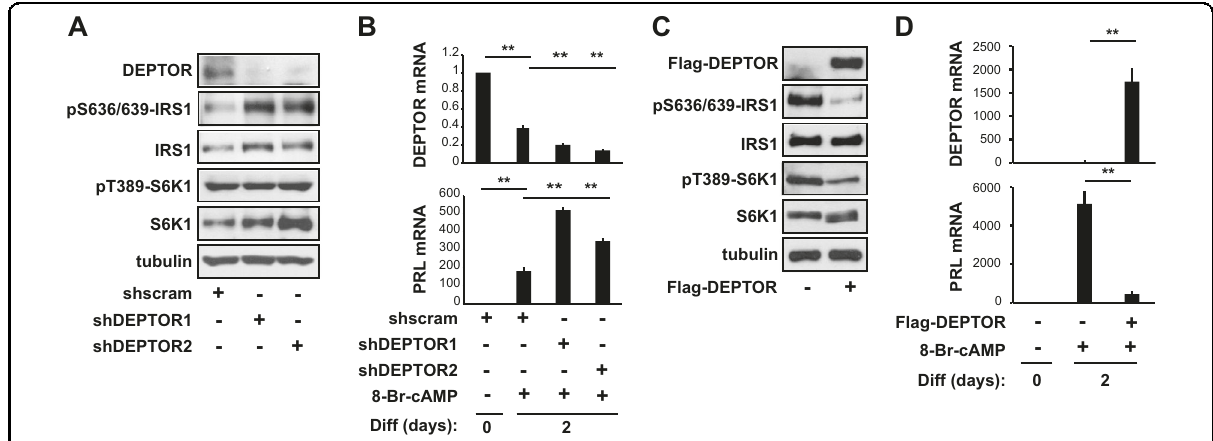
Fig. 4 DEPTOR is a negative regulator of decidualization. a , b Human endometrial stromal (hES) cells were infected with lentiviruses expressing two different DEPTOR shRNAs or scrambled shRNA and were then selected by puromycin for 5 days. a Cells were lysed and then analyzed by western blotting. b After 2 days of differentiation, the cells were lysed and subjected to quantitative RT-PCR. c Cells were transfected with Flag-DEPTOR, lysed, and analyzed by western blotting. d Cells were treated as described in ( c ), differentiated for 2 days, and then subjected to quantitative RT-PCR. Human GAPDH was used to normalize gene expression. All data are shown as the mean ± SD or are blots representative of three to fi ve independent experiments. Student ’ s t -tests were performed to compare the indicated pairs of data. ** P <